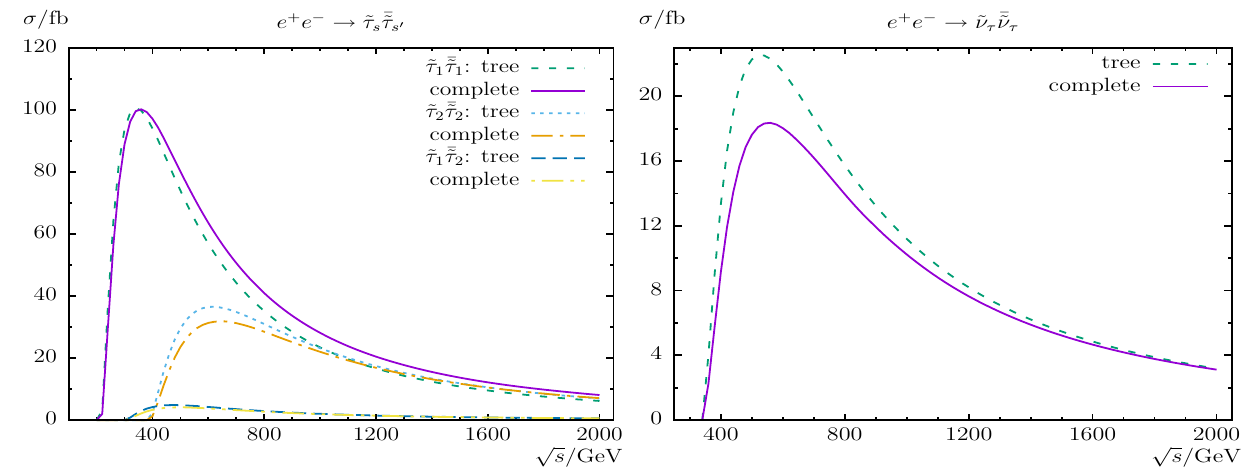
) (upper row) and σ( e + e − → ˜ ν τ ˜ ν ∗ Fig. 7 Comparison with Ref. [42] for σ( e + e − → ˜ τ + s ˜ τ − √ s (cid:3) s varied within the Scenario 1 according to Ref. [42] (relative corrections) with